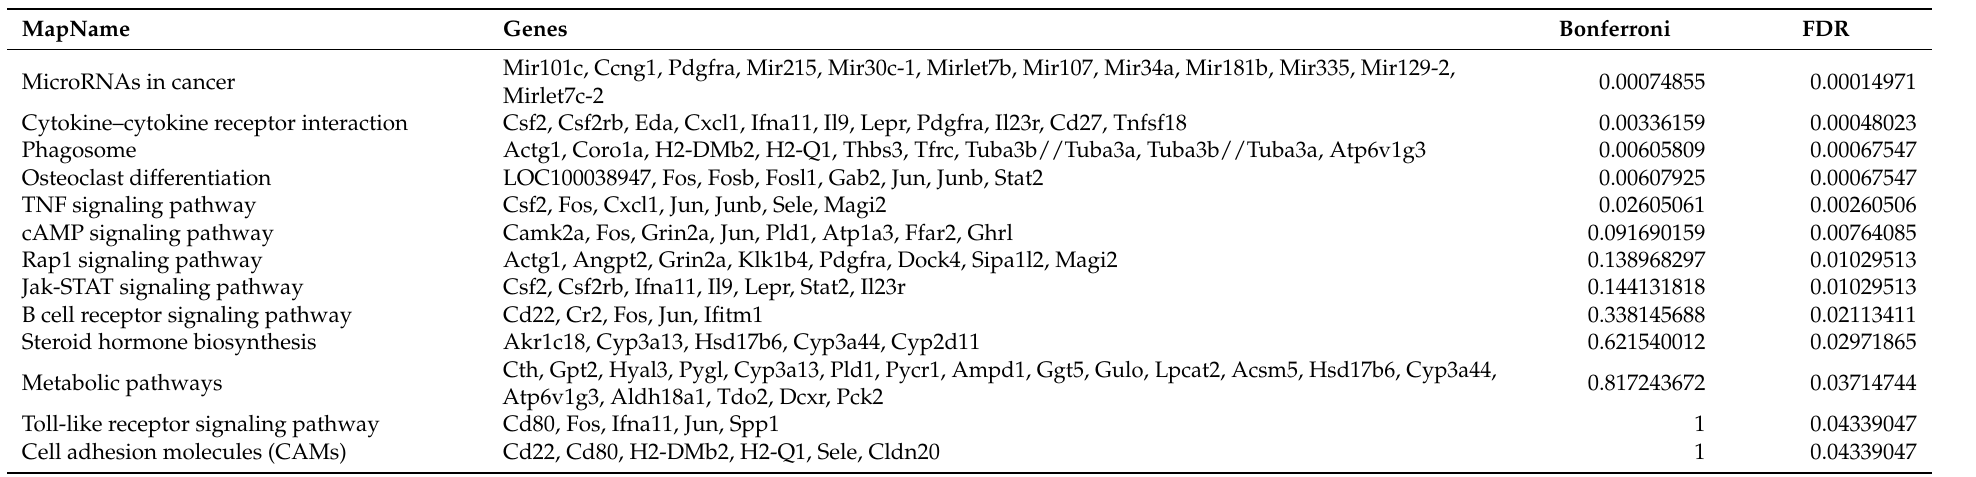
Table 2. Analysis of enrichment of KEGG pathways and involved genes in 48 h metformin-pretreated